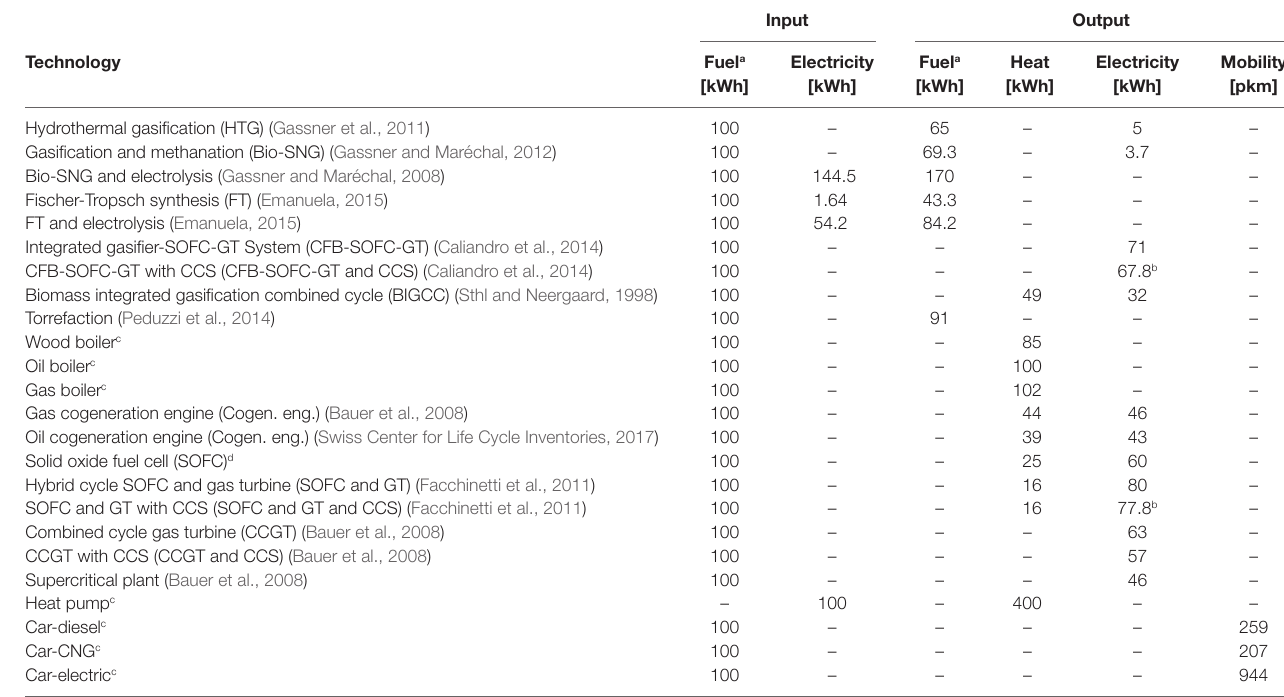
TaBle 2 | Efficiencies of the energy conversion technologies in